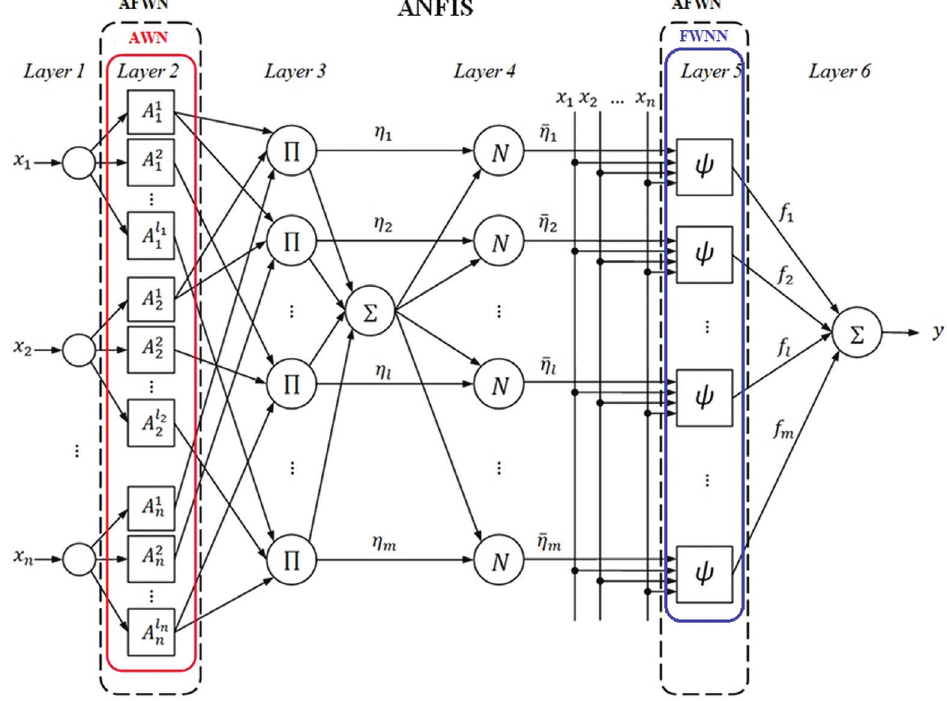
Figure 1. The Modifications Done on an ANFIS. FWNN [37] and AWN [23] (solid line) and AFWNN (dashed